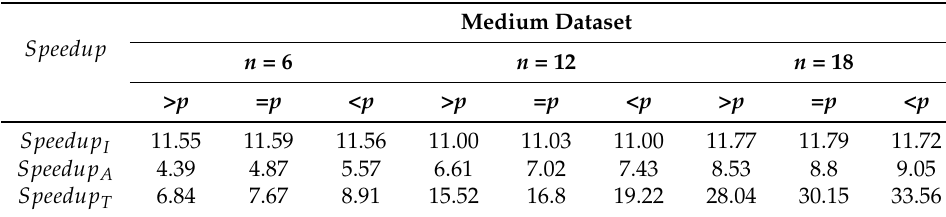
Table 7. Speedup obtained with a single card on Intel Xeon Phi (medium dataset).